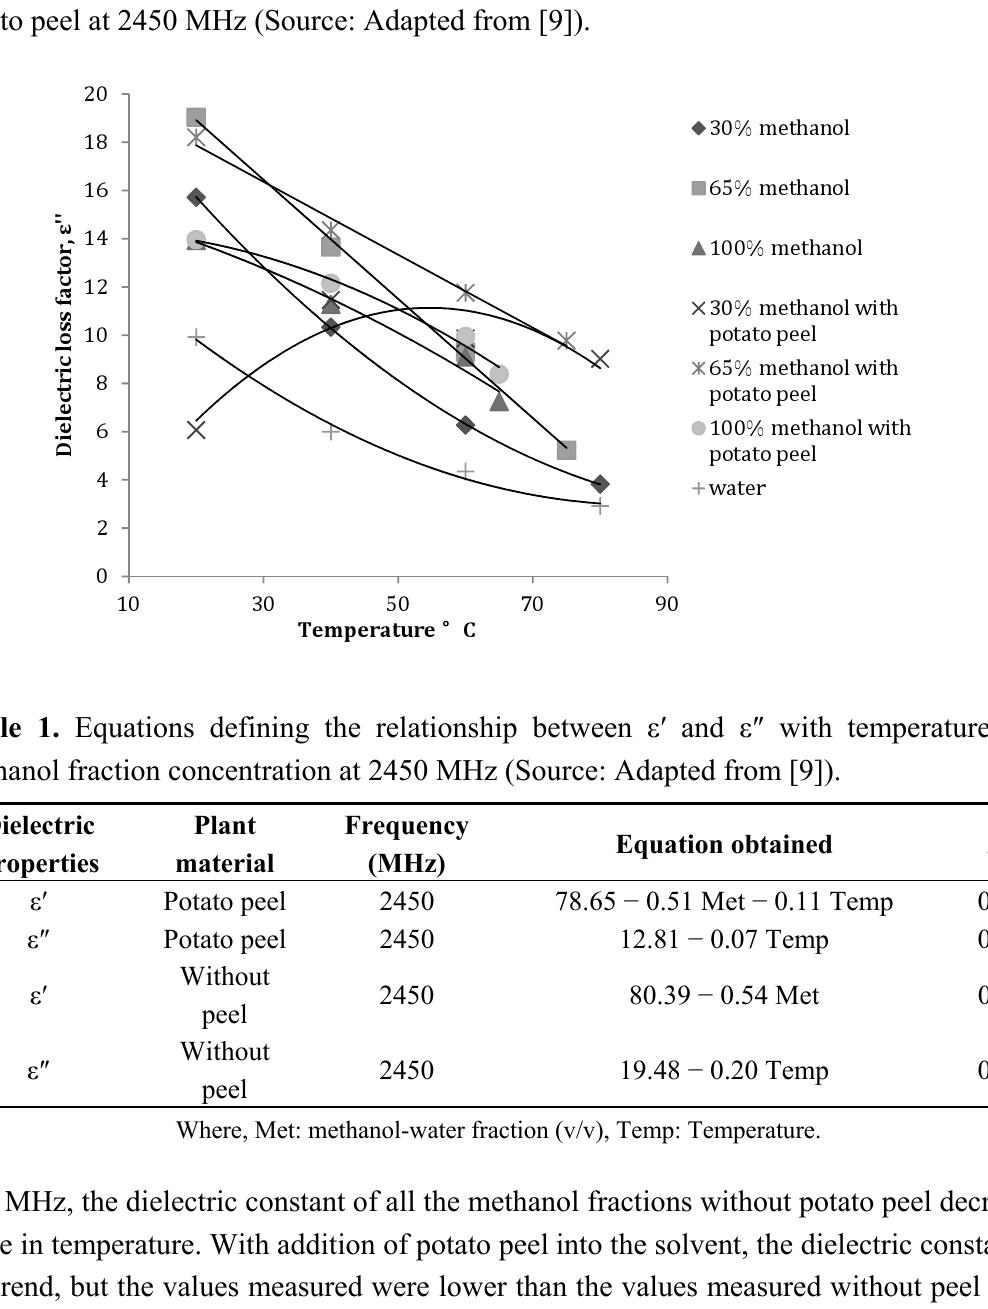
Figure 3. Variation in dielectric loss factor of a methanol-water mixture with and without potato peel at 2450 MHz (Source: Adapted from [9]).